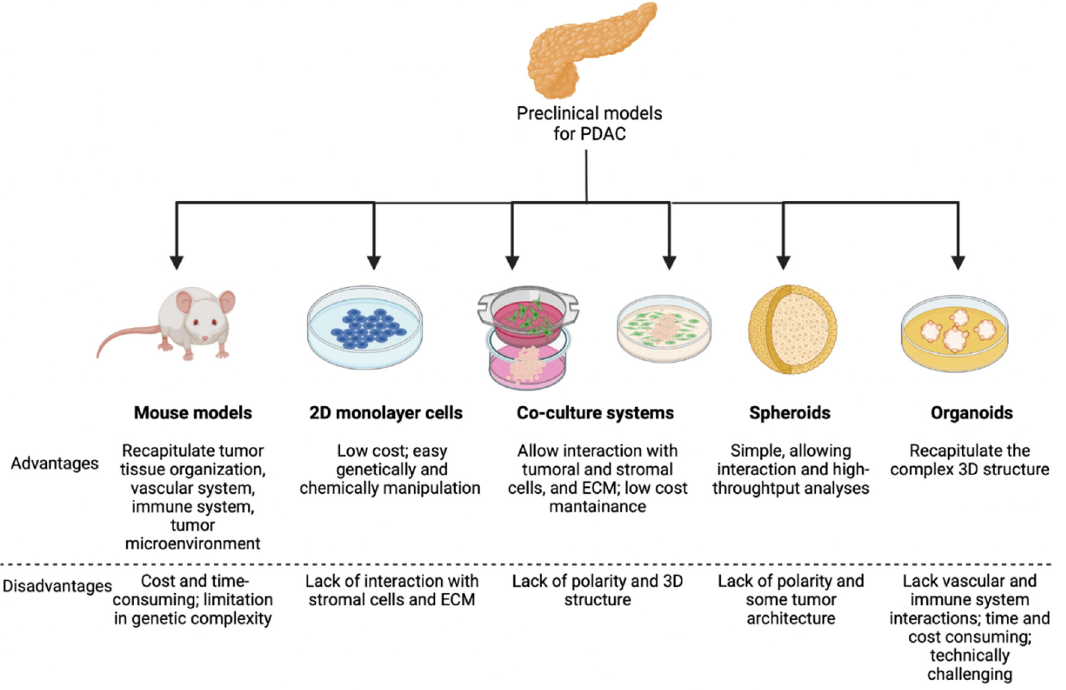
Figure 1. Scheme of the available preclinical models for PDAC studies, with their advantages and limitations. Created with BioRender.com (accessed on 10 June 2022).